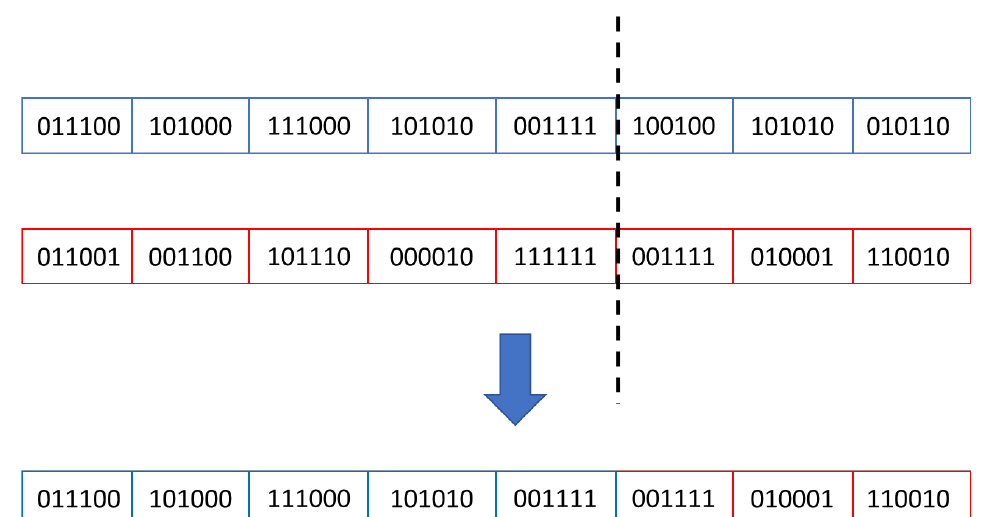
Figure 4. Representation of the crossover process. The crossover point (the point where individuals are split to exchange their second part) is randomly chosen during each crossover process.